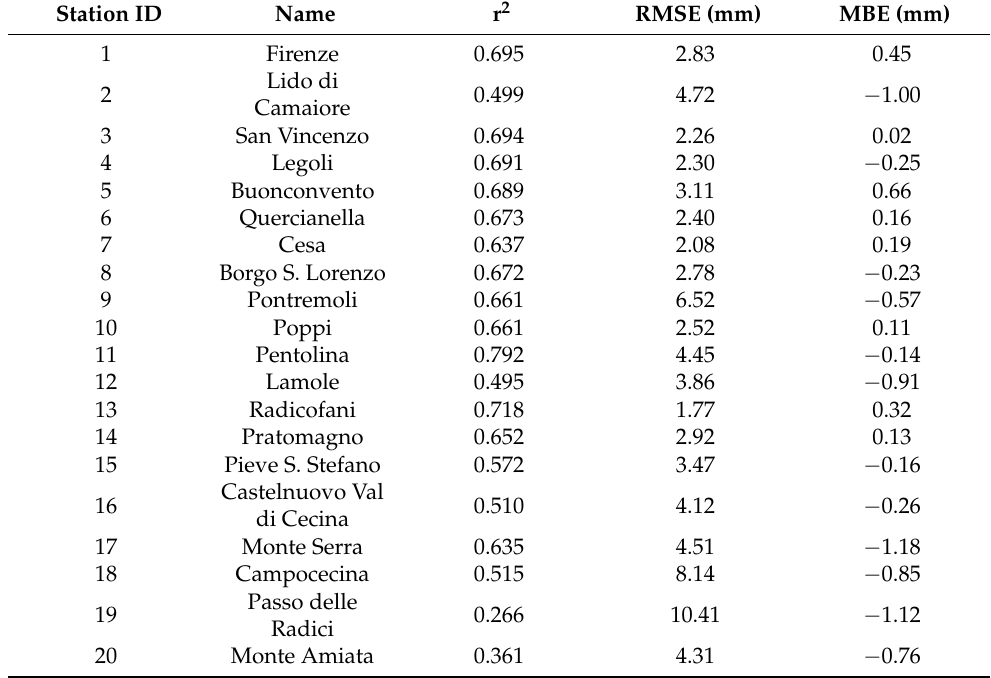
Table 2. Accuracy statistics of the remotely sensed daily precipitation estimates for the 20 ground weather stations over the study period (March–November